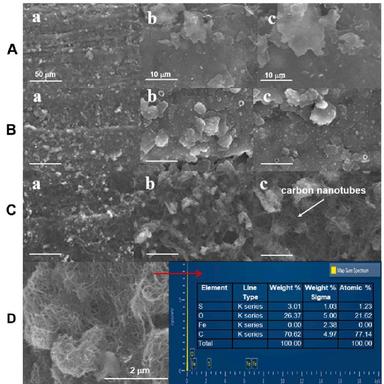
SEM images of A) PGE, B) PEDOT PGE, C) PEDOT NE ((a) scale bars: 50 μm, (b) up part of the electrodes, scale bars: 10 μm, (c) bottom part of the electrodes, scale bars: 10 μm), D) SEM image of PEDOT NE with a high resolution (scale bar: 2 μm) and EDS analysis for the PEDOT NE.